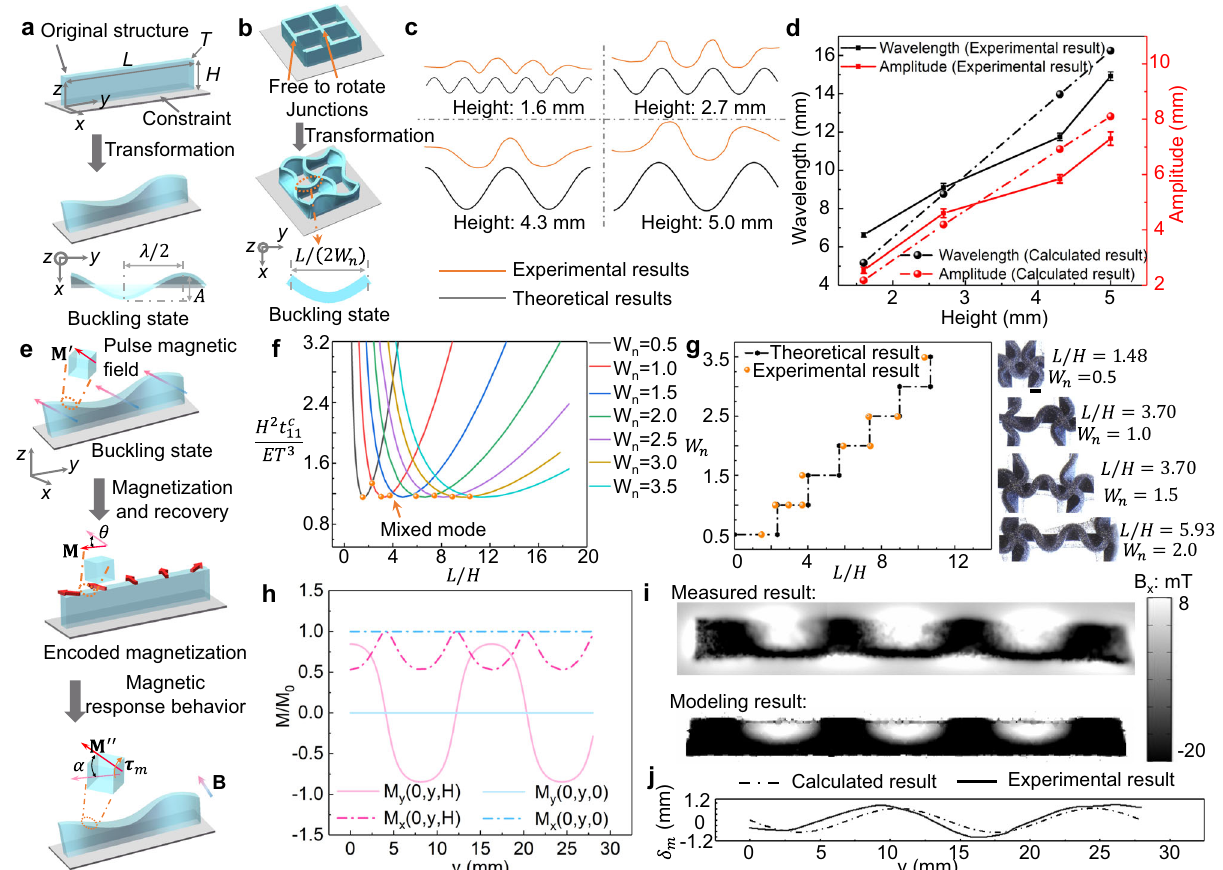
Fig. 3 | Theoretical model for solvent and magnetic responsive behaviors of t c 11 areYoung ’ smodulusandcriticalmembraneforce,respectively.Discretedotsin soft structures. a Transformation of elastomer strip with length L , height H , and orange color represents the experimental results, which can also be found in thickness T under solvent stimulus. λ represents the wavelength. A is the peak-to- Fig.3g.Theintersectionofthetwocurvesindicatesthatmixeddeformationmodes peak value. b Transformation of elastic plate with free-to-rotate junctions under would occur. g Theoretical and experimental results for the relationship between solvent stimulus. L is the distance between two junctions. The wavelength λ n is the W n andtheaspectratioundersolventstimulus.Whentheaspectratioreachesa determined by λ n = L = W n , where W n represents the deformation mode of strip. critical value, the strip would exhibit mixed deformation modes. As the experi- c Comparison of the deformed shape of the free edge ( z = H ) of the strip structure mental results with L/H =3.70, W n can be equal to 1.0 or 1.5. When L/H =7.41, W n can be equal to 2.0 or 2.5. h Magnetization pro fi le of the strip at z =0 and z = H with theoretical results. d The impact of the height of the strip on the wavelength and amplitude under solvent stimulus. e Schematic diagram of the magnetization process, the change of magnetization pro fi le during the recovery process, and the magnetic actuation process. f The relationship between the normalized critical (cid:3) andaspectratio( L/H )underdifferentdeformationmodes,where E and force H 2 t c 11